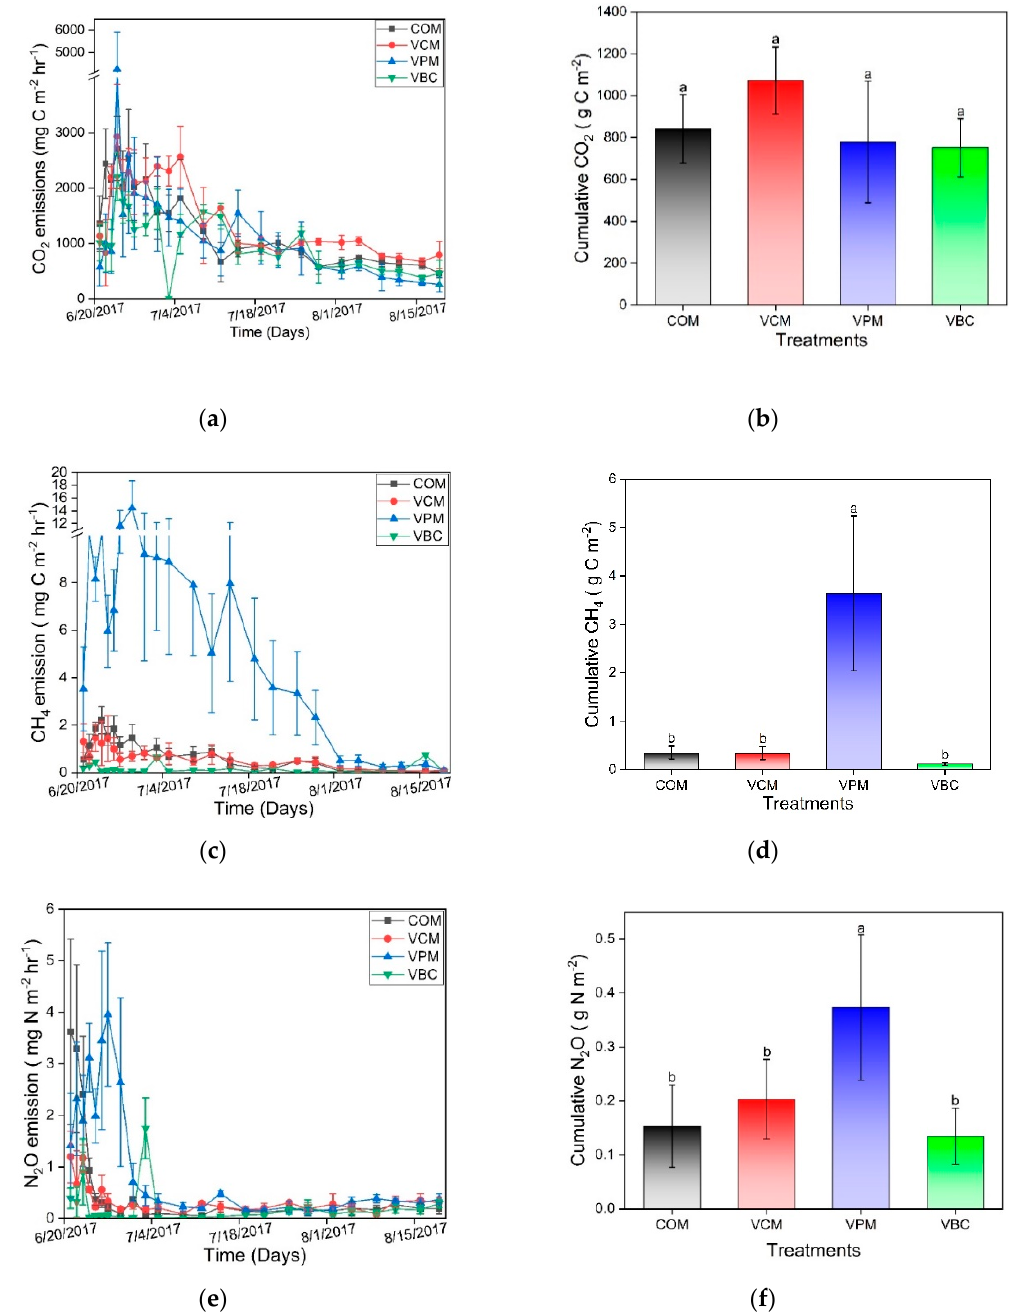
Figure 6. ( a ) Carbon dioxide emissions, ( b ) cumulative carbon dioxide, ( c ) methane emissions, ( d ) cumulative methane emissions, ( e ) nitrous oxide emissions, and ( f ) cumulative nitrous oxide emissions in all treatments for the whole experimental duration as mean of three replicates. Error bars represent standard errors. Different letters indicate significant differences among the treatment ( p < 0.05).